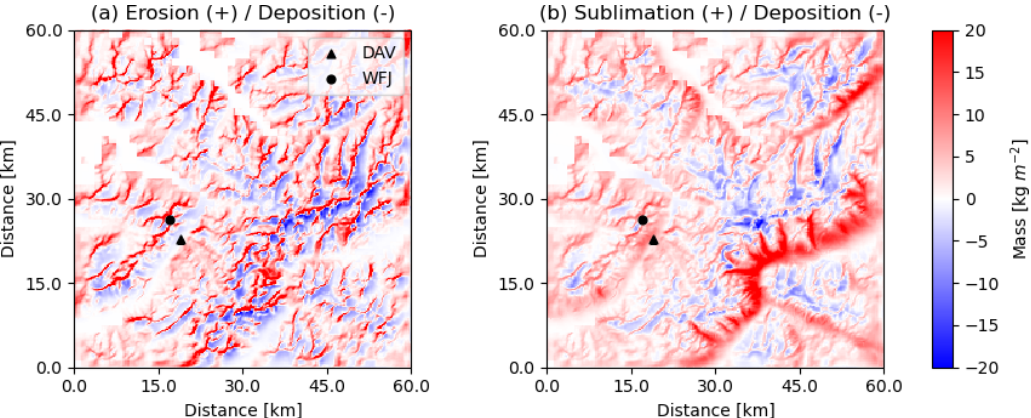
Figure 15. Impact of blowing snow. (a) Erosion and deposition of snow at the surface due to snow transport. (b) Sublimation (or deposition) of blowing snow particles in the atmosphere. Stations DAV and WFJ are marked by a black triangle and circle,